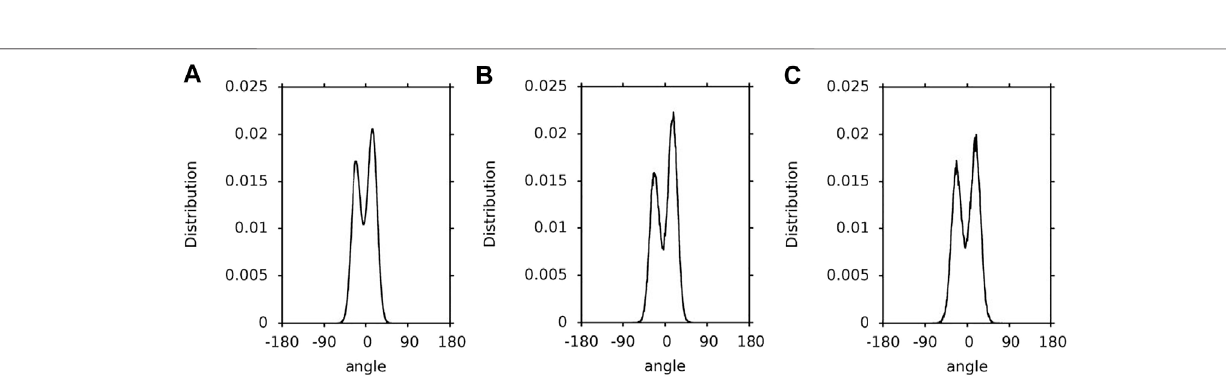
FIGURE 3 | Population distributions of lutein C5 ′ -C6 ′ -C7 ′ -C8 ′ torsions angles ( ε -ring torsion). (A) in the PC-LUT bilayer; (B) in water; (C) in vacuum.